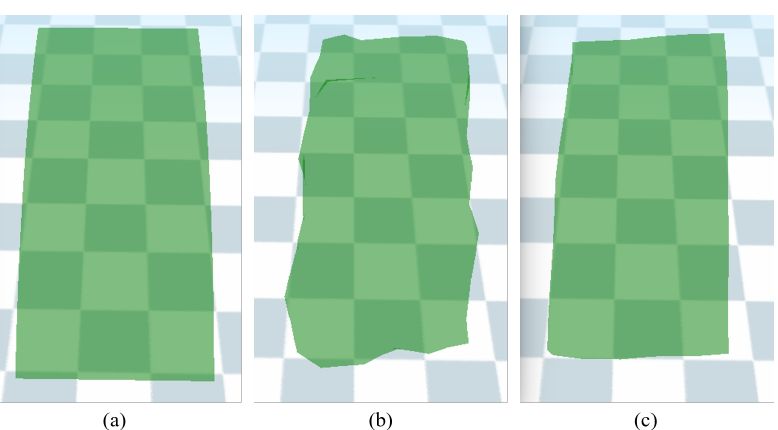
Figure 7. Model deformation: ( a ) initial shape, ( b ) deformed shape from updated feature vectors, and ( c ) deformed shape from the FEM